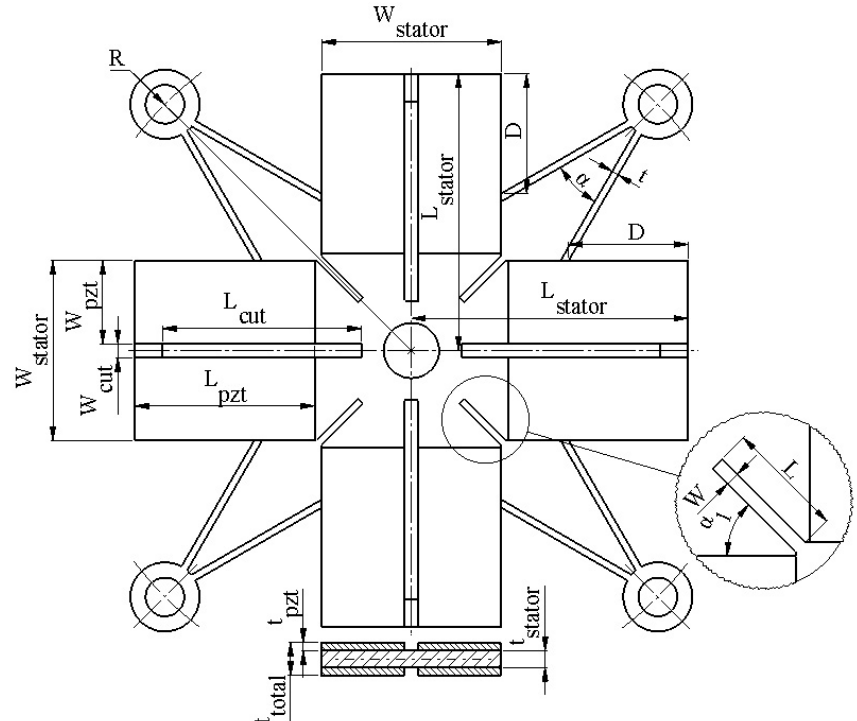
Figure 2. Schematics of the stator. Table 1. Geometrical parameters of the stator.